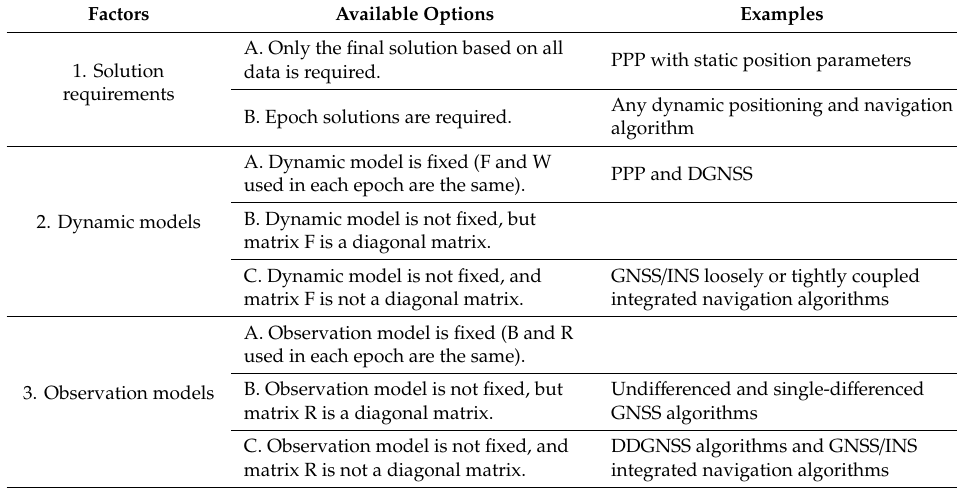
Filter factors. point